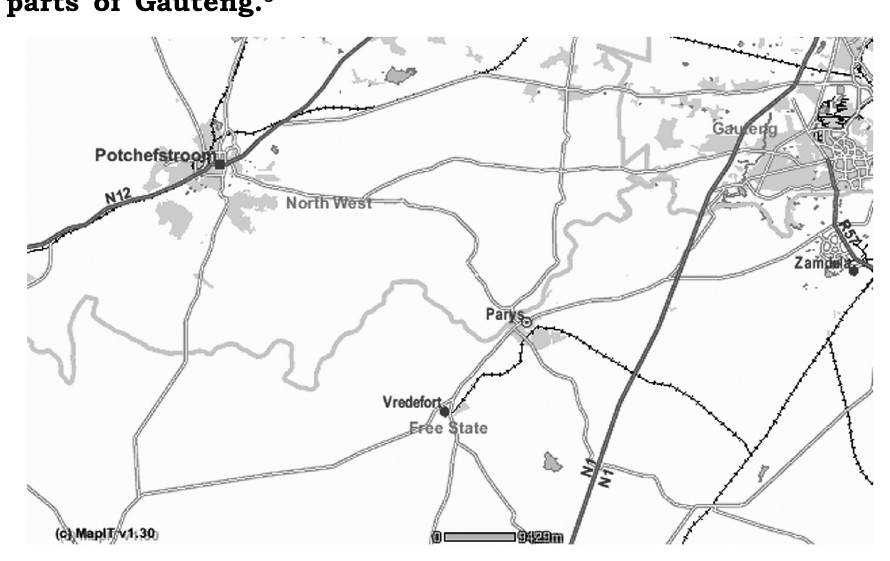
Figure 1 Map of Parys in the Northern Free State, Potchefstroom North West Province and the south-western parts of Gauteng.